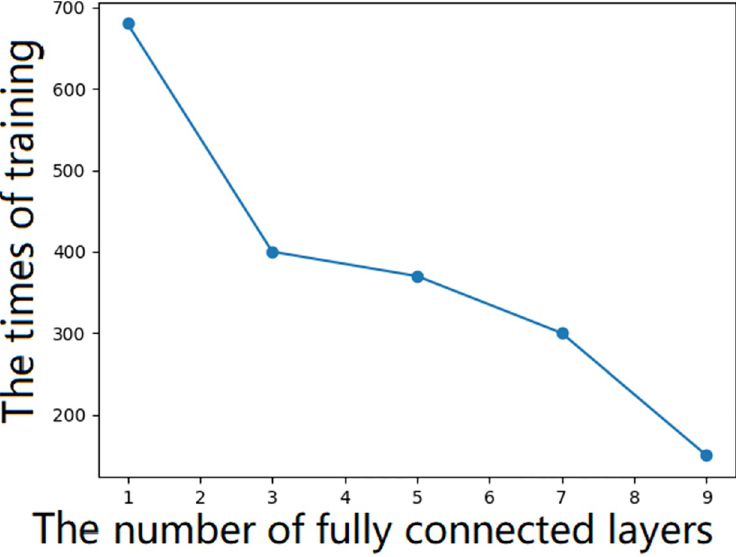
Fig 6. Comparison of fitting results obtained using the different models in the four